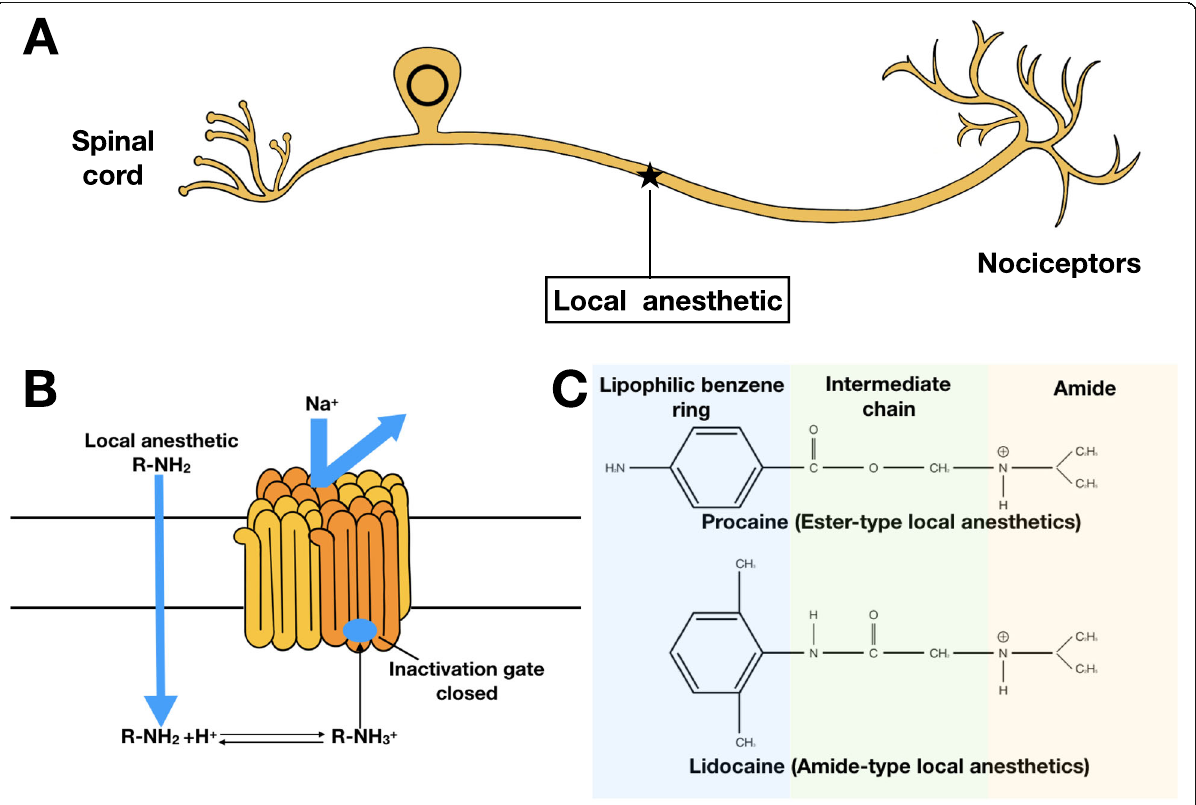
Fig. 1 Functional and Structural Properties of LAs. a , b Demonstration of how LAs interact with voltage-gated sodium channel on neuron. c Typical structures of ester and amide